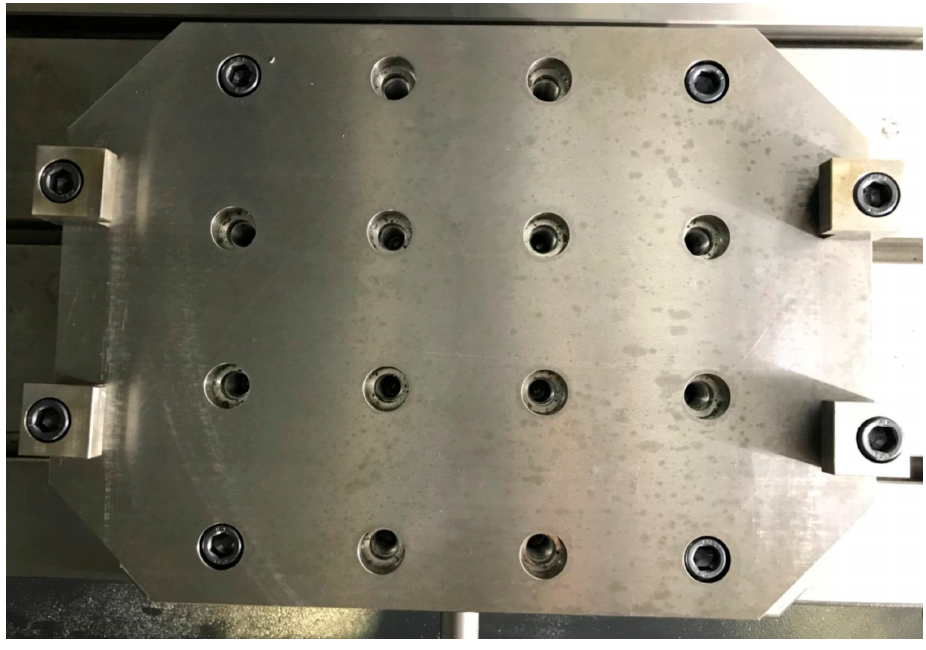
Figure 2. The adapter tray fixture.